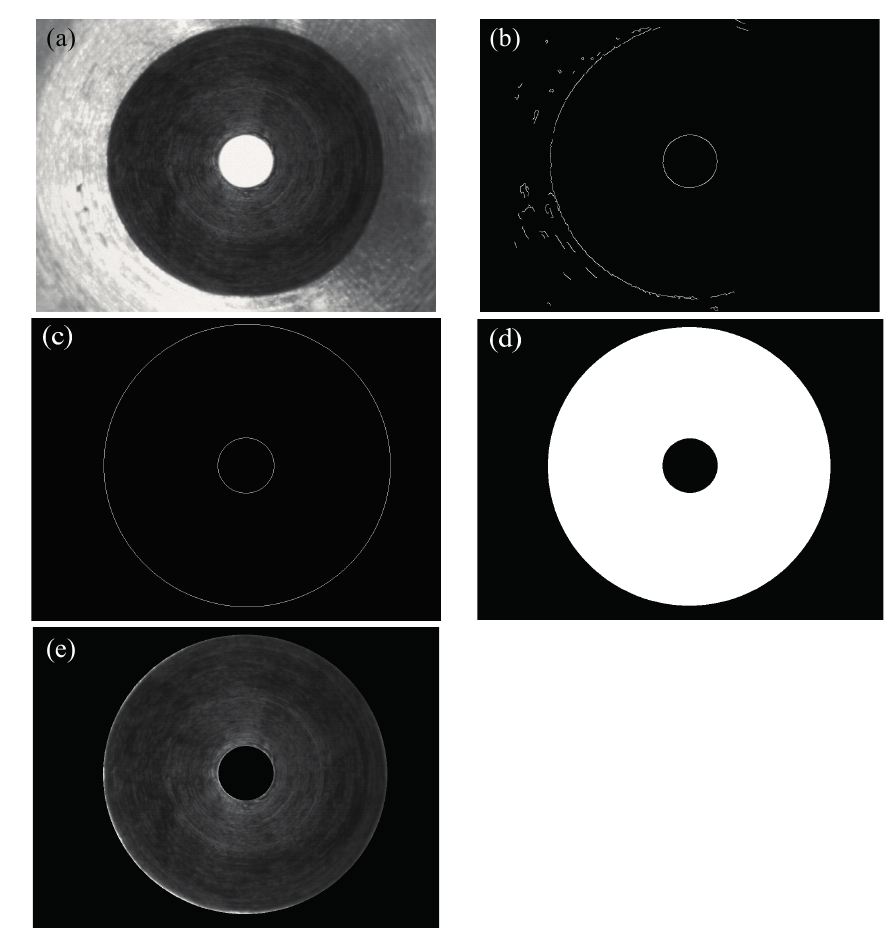
Figure 7. ( a ) Original image; ( b ) after Canny edge detection; ( c ) randomized algorithm for detecting circles; ( d ) the image after hole-filling operation; ( e ) ROI image with the AND logic operator for